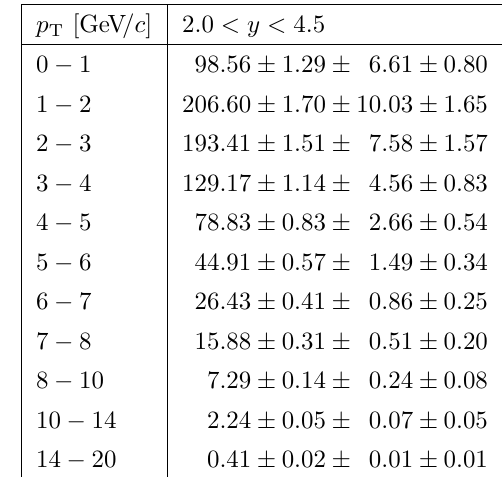
Table 4 . Single-differential production cross-sections d σ [nb/(GeV/ c )] for prompt J/ψ mesons in d p T the rapidity range 2 − 4 . 5 . The first uncertainties are statistical, the second are correlated systematic uncertainties shared between intervals, and the last are uncorrelated systematic uncertainties.